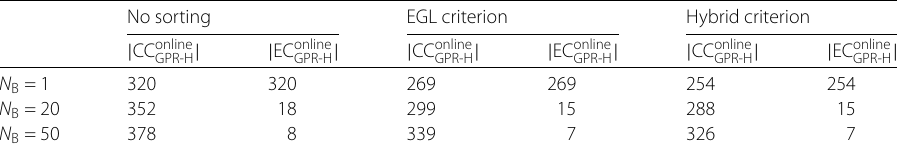
Table 3 Comparison of the number of online CST calls | CC online GPR-Hybrid approach with different updating